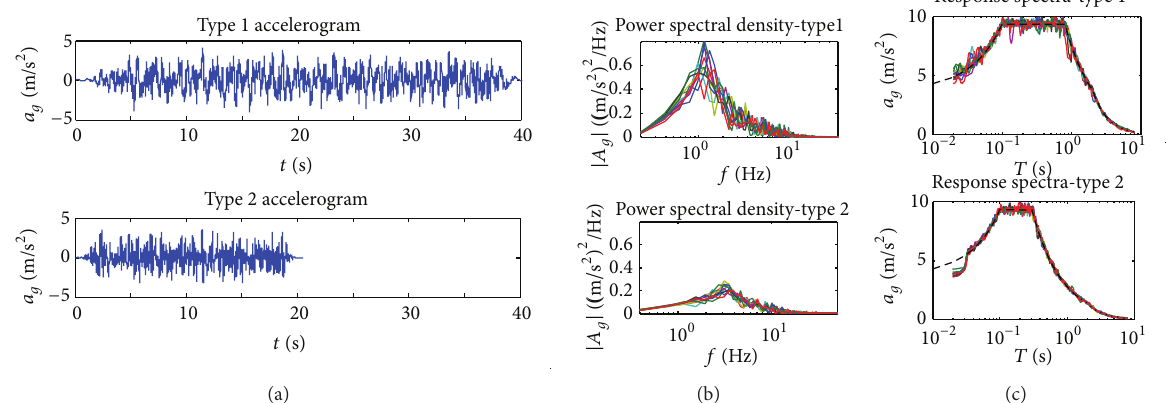
Figure 4: Input ground motions characteristic considered in the numerical simulations. (a) One of ten artificial accelerograms; (b) frequency spectra of 10 accelerograms; (c) response spectra of 10